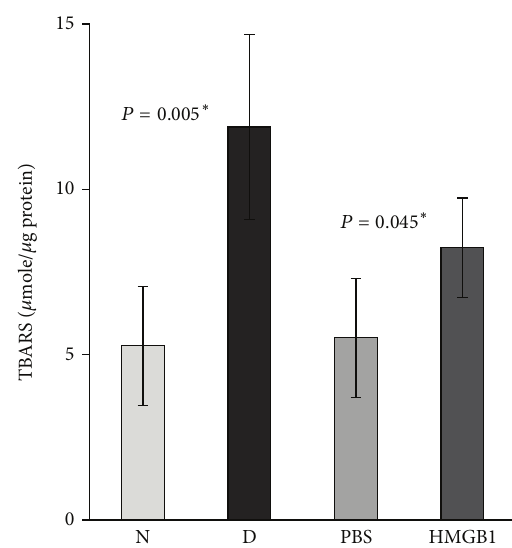
Figure 3: Levels of thiobarbituric acid reactive substances (TBARS) are significantly higher in the retinas of diabetic rats (D) compared with the nondiabetic control rats (N). Intravitreal administration of high-mobility group box-1 (HMGB1) induced a significant upregulation of the levels of TBARS compared with intravitreal administration of phosphate buffer saline (PBS). Each experiment was repeated 2 to 3 times with fresh samples ( 𝑛 = 6